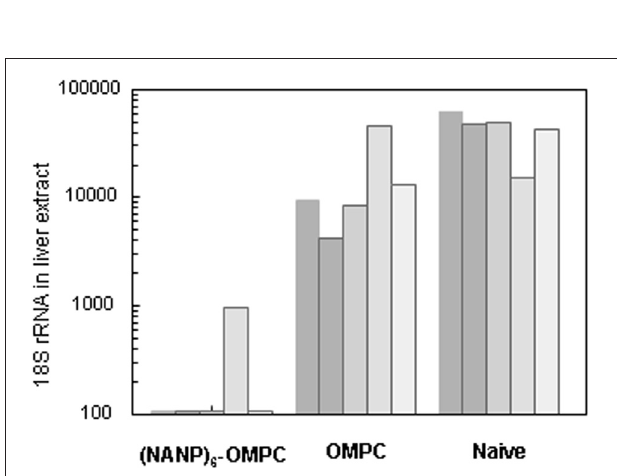
cell extracts collected after 48h of culture were measured by qPCR. Results are shown as mean number of parasite 18S rRNA copies in cell extracts, based on an 18S rRNA plasmid standard. (C) Individual sera of 10 C57Bl/6 mice were tested in TSNA at dilutions of 1:10–1:40. Dotted line indicates 90% inhibition level.